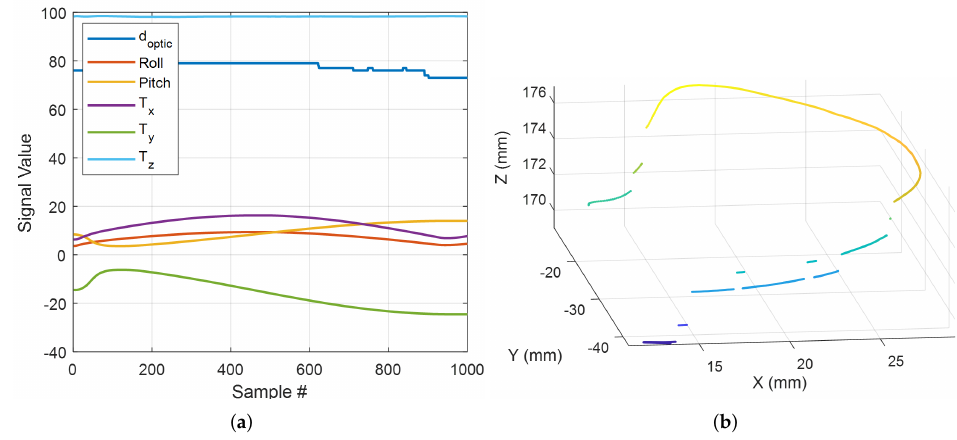
Figure 5. 3D point cloud generation ( a ) a sample of tissue surface scanning procedure raw data; ( b ) 3D point cloud of the tissue surface generated from the raw